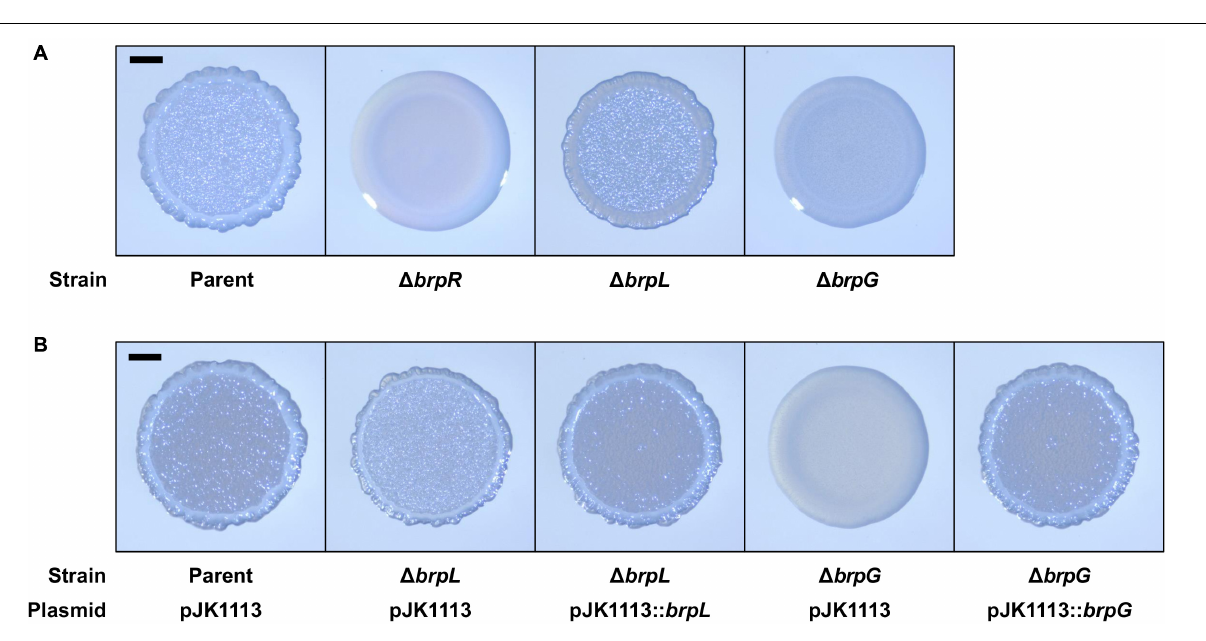
FIGURE 6 | Colony rugosity impaired by the deletion of brpLG . (A) The parent and mutant strains were spotted onto VFMG agar supplemented with 0.02% arabinose and incubated for 24 h. (B) The parent and mutant strains were spotted onto VFMG agar supplemented with 0.02% arabinose and 100 µ g/ml kanamycin and incubated for 24 h for complementation experiments. Each colony that represented the mean rugosity from at least three independent experiments was visualized using a stereomicroscope. All images are shown at the same scale, and 1-mm scale bars are shown on the images of the parent